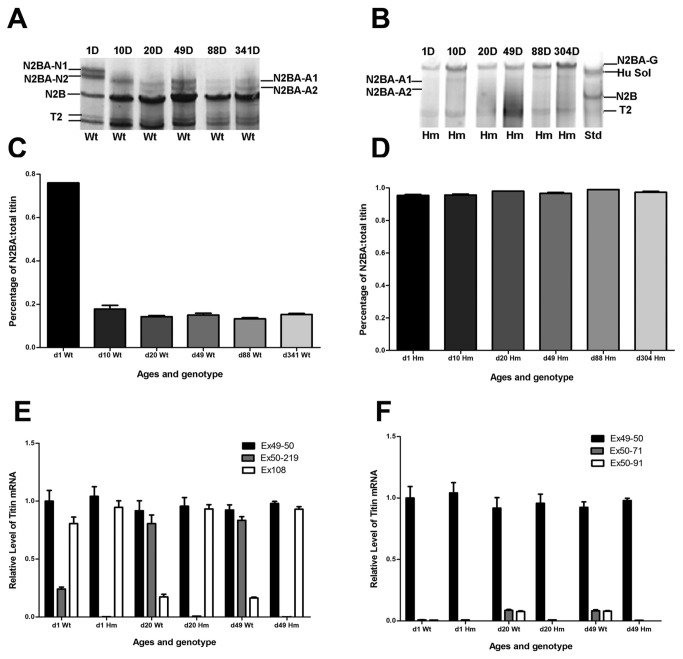
Developmental changes in expression of titin protein isoforms and mRNA in wild type (Wt) and homozygote (Hm) mutants.Proteins were separated by SDS agarose electrophoresis [16]. D: days after birth; Std: mixture of human soleus (3.7 MDa) & rat N2B (3.0 MDa); T2, titin fragment; Ex, exon. A. Larger N2BA isoforms (3.6 to 3.7 MDa) were present at one day after birth and disappeared with age in normal rats during development. B. A different larger N2BA isoform (3.8 MDa) appeared in mutant homozygote rats; the smaller N2B and other shorter N2BA isoforms were essentially absent at all ages. C. The smaller N2B isoform increased in proportion with age and reached approximately 85% (P<0.01) from 20 days of age and older in wild type. D. The larger N2BA isoform in homozygous mutants constituted nearly 100% (P<0.05) of the total titin. E. Relative titin mRNA expression in wild type and mutant rats determined by Q-PCR. All data are from an average of triplicates (P<0.05). Primers for exons 49 to 50 would prime both N2B and N2BA titin isoforms; primers for exons 50 and 219 would amplify the N2B only, and primers for exon 108 would amplify the N2BA isoforms only. F. Relative mRNA expression of other pre-identified titin isoforms to total titin in wild type and mutant rats. Total titin of 1 day Wt was defined as 1.0 for all the comparisons.